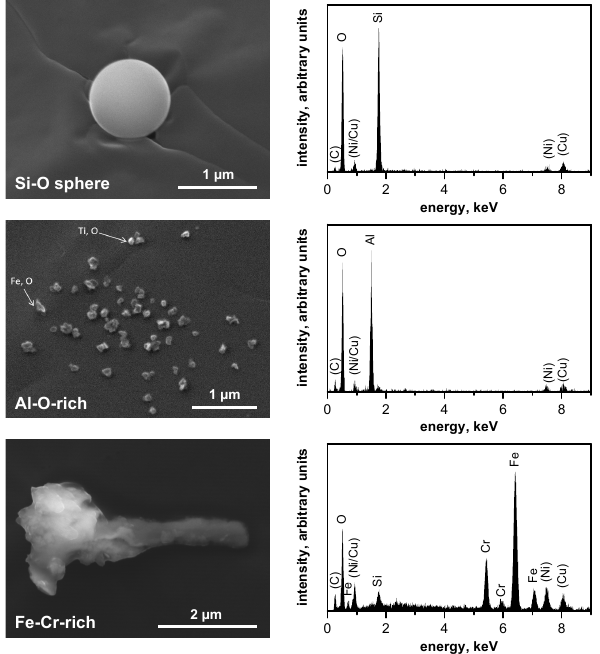
Figure 2. Secondary electron images and energy-dispersive X-ray spectra of instrumental contamination artifact particles. Character- istic X-ray peaks of elements are labeled. Elements contained in the sample substrate are given in parentheses. the dominating artifact particles for each instrument is shown in Fig. 3 as box plots.